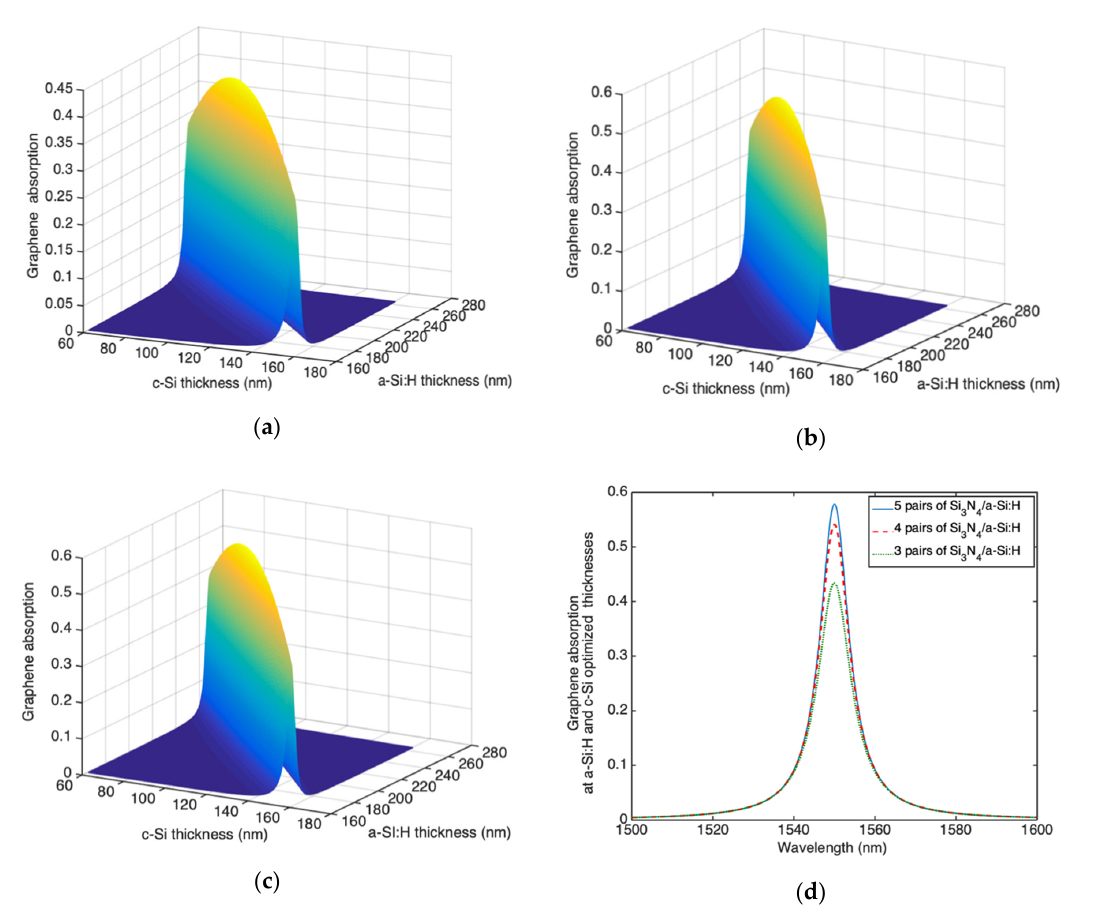
Figure 7. Graphene absorption as function of both c-Si and a-Si:H thicknesses for the transverse collection configuration (TCC) Fabry–Pérot graphene/Si Schottky PD provided of a DBR output mirror constituted by ( a ) 3, ( b ) 4 and ( c ) 5 pairs of Si 3 N 4 /a-Si:H and ( d ) spectral graphene absorption at the optimized c-Si and a-Si:H thicknesses.